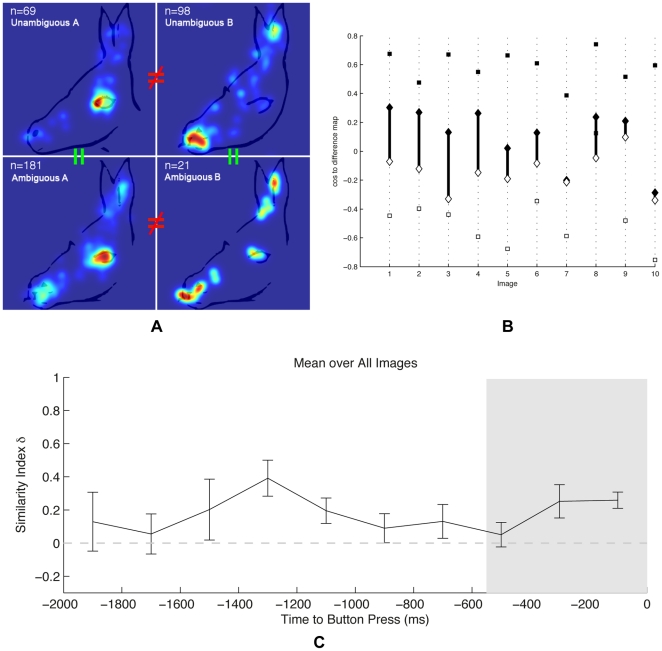
Viewing behavior prior to awareness.(a) Examples of viewing behavior prior to object awareness on the ambiguous and unambiguous stimuli with corresponding percepts. There are significant differences between the groups with different percepts (as indicated by the KL divergence analysis), and the differences in the viewing behavior on the ambiguous and unambiguous stimuli are aligned with identical percepts (as shown by the similarity index δ). The shown fixation patterns correspond to the fifth-largest index value out of the ten examined stimulus sets. (b) The cosine values underlying the similarity index calculation for the individual fixation density maps (FDM). Filled symbols represent percept A, the empty ones percept B. Squares denote cosines calculated from the unambiguous FDMs; diamonds indicate values calculated from the ambiguous FDMs. Image 1 corresponds to the example shown in (a). (c) The time-analysis showing the index-peak at about 1330 ms before the button press. Error bars are s.e.m. The shaded area marks the time during which data would be discarded according to the pupil analysis.